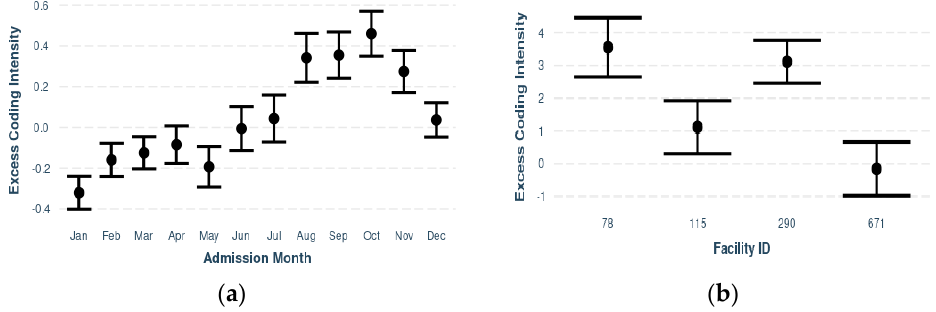
Figure 1. Effect plot illustrating excess coding intensity by admission month ( a ), and effect plot of excess coding intensity estimates for a stratum of hospitals with the same values (modal categories for each variable) for all facility-level characteristics ( b ).